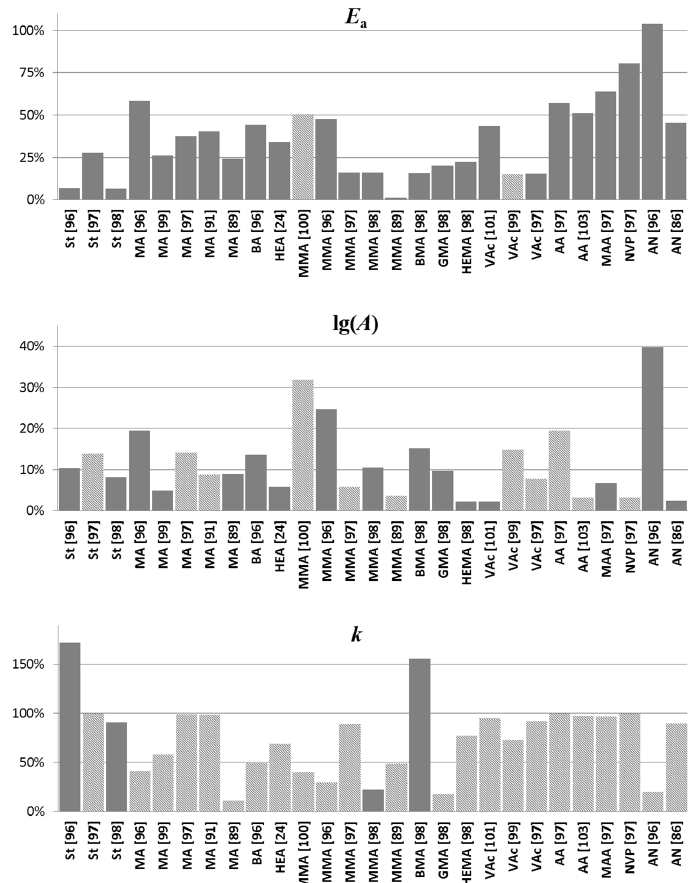
Figure 1. Mean unsigned error between experimental and computational results ( cf. data in Tables 1 and 2, respectively) of activation energy, E a , pre-exponential factor, lg( A ), and rate constant at 50 °C, k , for the propagation reactions of various FRP systems. For each column, the number between square brackets indicates the literature source of the computational value adopted, with reference to the data in Table 2. The QC data either overestimate (filled columns) or underestimate (striped columns) the corresponding experimental parameters.